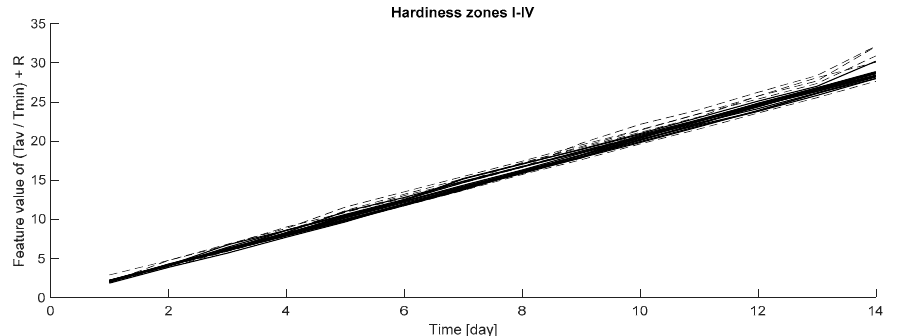
Figure 8. The cumulative summed feature values (y-axis) for the cases’ reference data vs. independent category 2 data. The weather data used included hardiness zones I–IV.